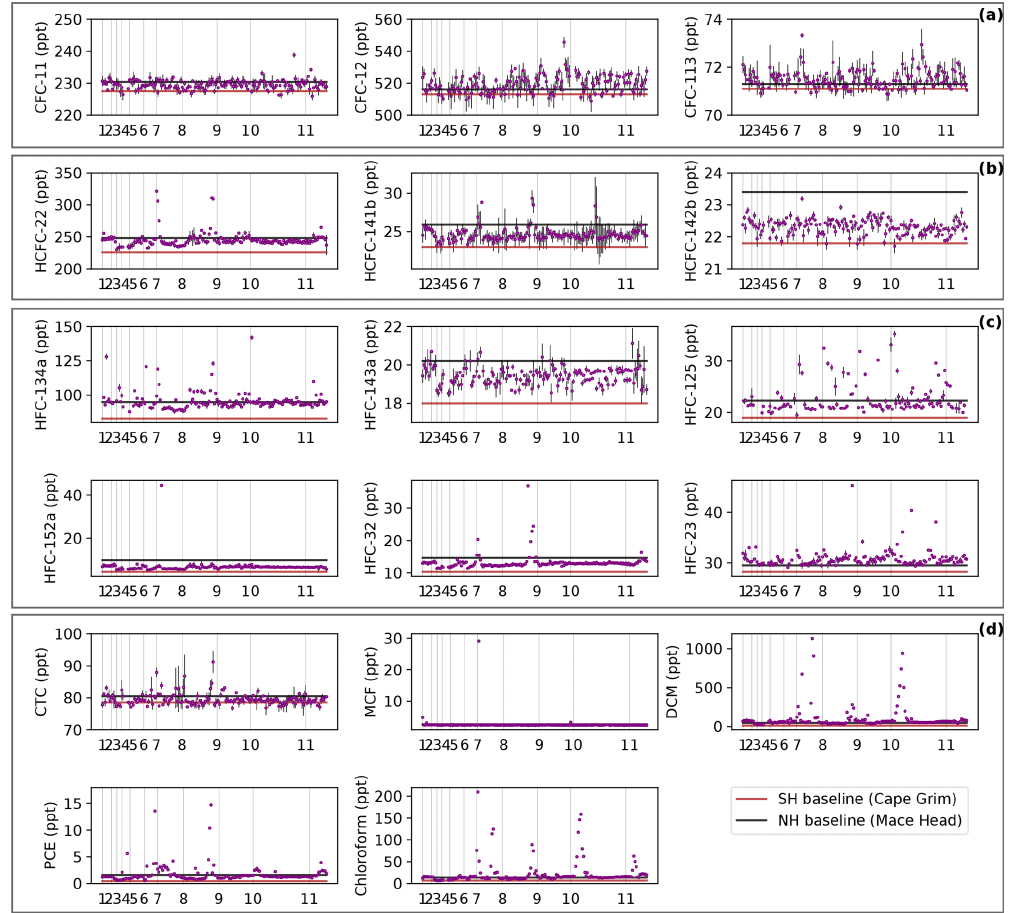
Figure 2. (a) CFC, (b) HCFC, (c) HFC and (d) chlorocarbon mole fraction data from 176 flask samples collected over India, plotted on a flight by flight basis (a summary of flights 1–11 is given in Table 2). Error bars represent instrumental precision, which was estimated using the standard deviation of the three replicate analyses of each flask. Two statistical baselines, inferred from observations at Cape Grim, Tasmania (red line), in the Southern Hemisphere (SH) and Mace Head, Ireland (black line), in the Northern Hemisphere (NH), are shown for